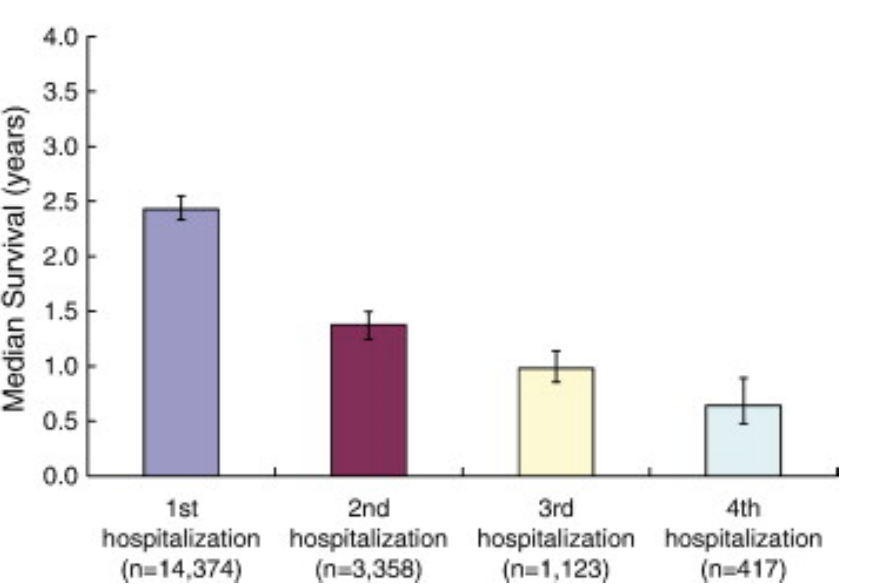
Figure 2. The effect of repeated heart failure hospitalizations on patient survival. Reprinted from American Heart Journal, Volume 154, Issue 2, Setoguchi et al., Repeated hospitalizations predict mortality in the community population with heart failure, Pages 260–266, Copyright 2007, with permission from Elsevier [4].